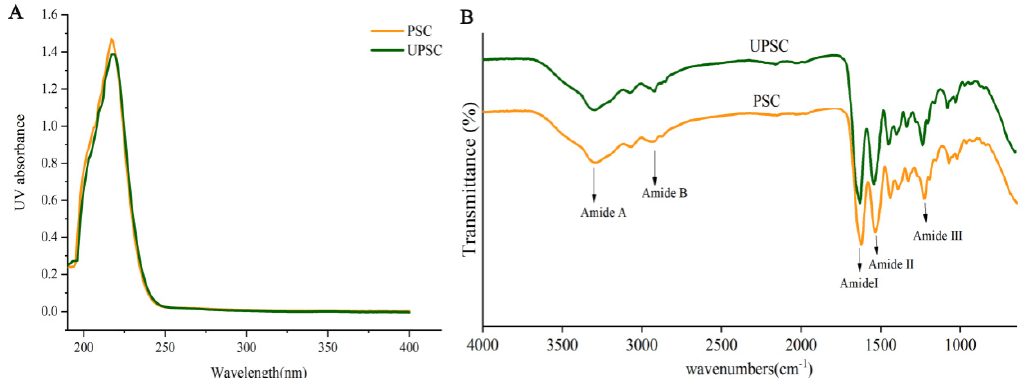
Figure 2. Bactrian camel skin collagen samples’ UV absorption spectra ( A ) and Fourier transform infrared spectra ( B ) (PSC, pepsin-solubilized collagen; UPSC, ultrasound − treated pepsin − solubilized collagen).